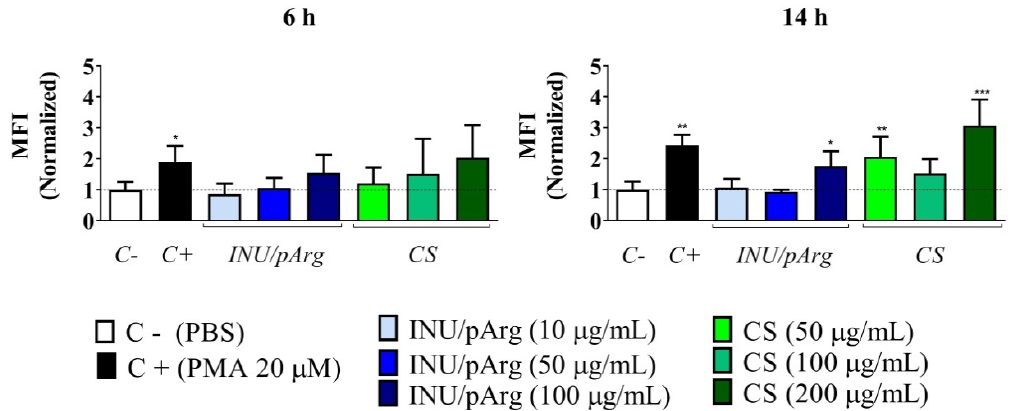
Figure 5. Reactive oxygen species (ROS) release in HL-60 cells incubated with CS and INU/pArg nanocapsules at three different concentrations during 6 and 14 h. CS: Chitosan, INU: Inulin and pArg: Polyarginine, PMA: Phorbol 12-myristate 13-acetate. Statistical significance: * P ≤ 0.05, ** P ≤ 0.01, *** P ≤ 0.001.